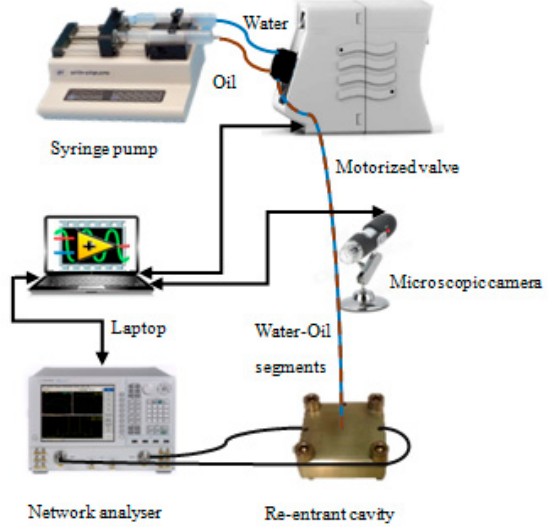
Figure 6. The complete microfluidic system connected to the cavity sensor and controlled via LabVIEW code. The microscopic camera has been used for video recording.